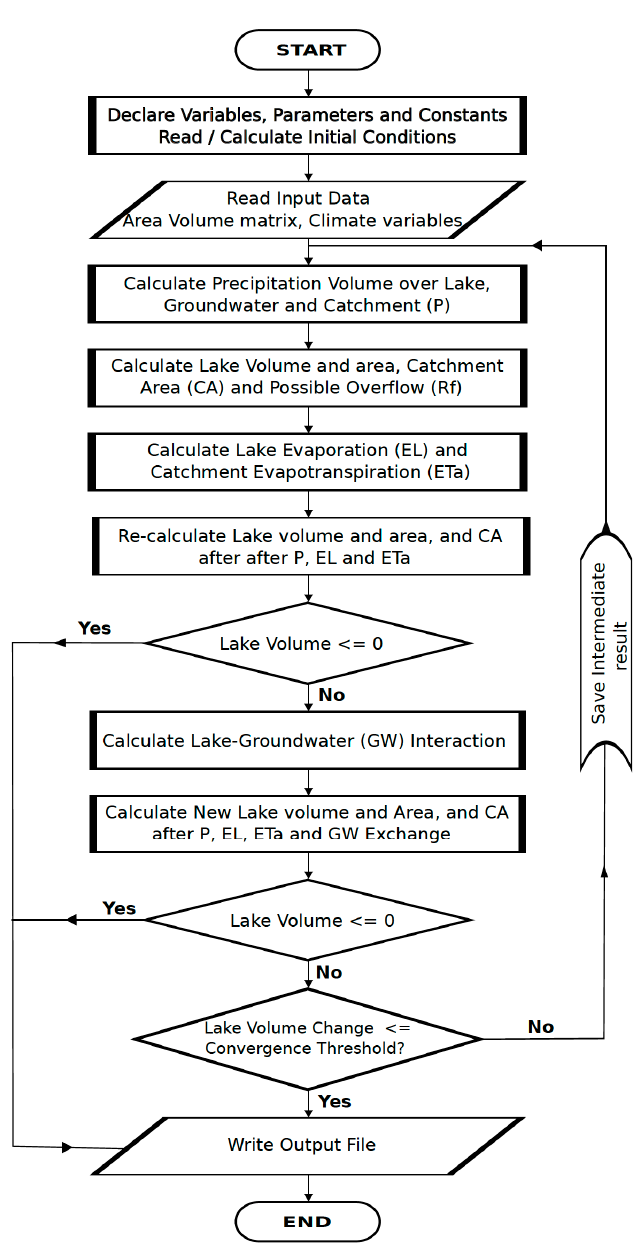
Figure 5. Workflow of the water balance model calculation.